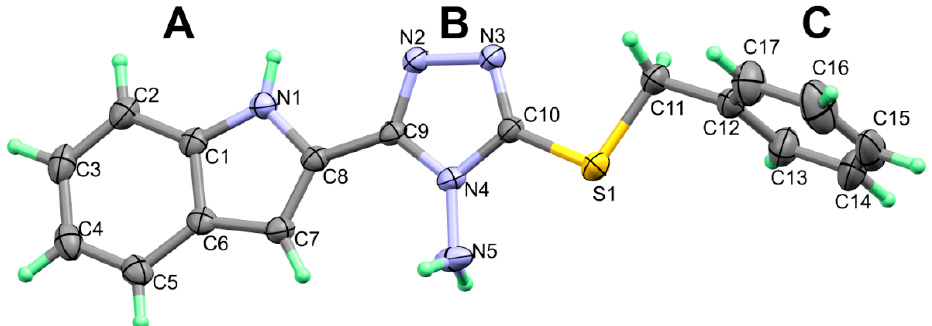
Figure 1. X-ray structure showing atom numbering and thermal ellipsoids at 30% probability level.